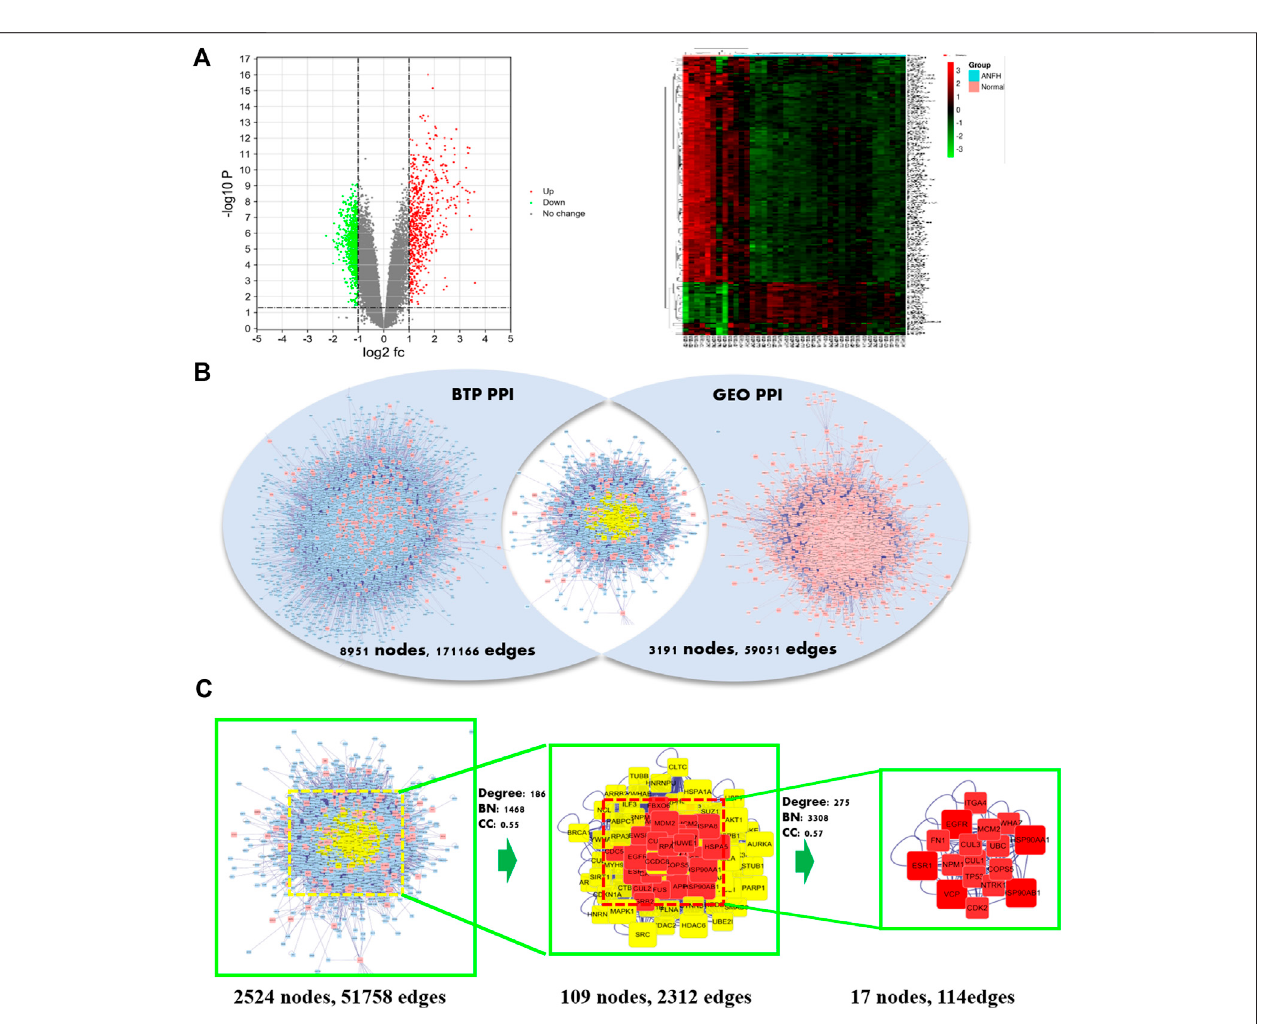
FIGURE3| Volcano plot (left) and heatmap (right) ofdifferentially expressed genes(DEGs)inmicroarraydatasets ofGSE123568 (A) .Intersection PPInetworkof BTP and DEGs. (B) Identi fi cation process of core targets of BTP against ONFH. Nodes for genes and edges for interactions between proteins (C) .